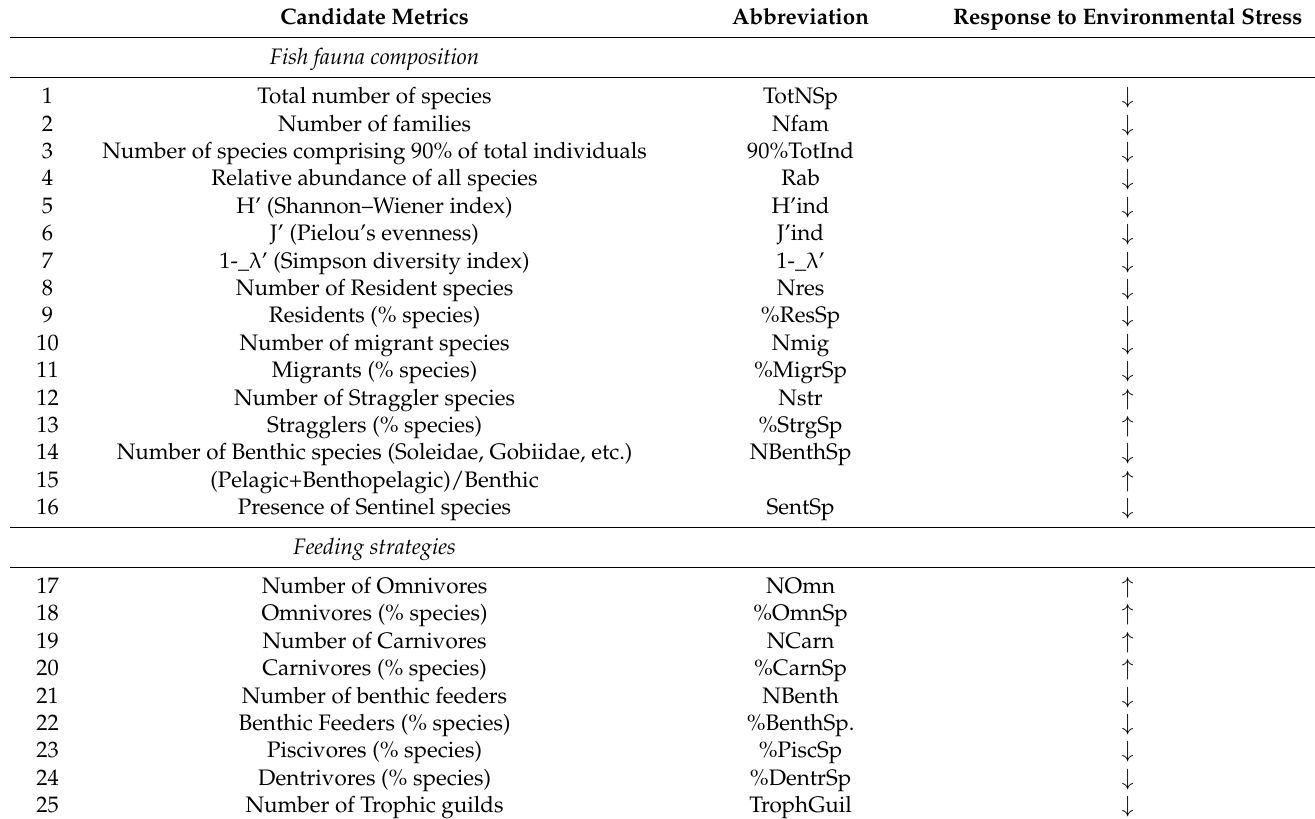
Table 1. The 25 potential metric indicators that were tested during the development of the Fish-based River Integrity Index and their predicted response to various stressors. All potential metrics were included in other indices